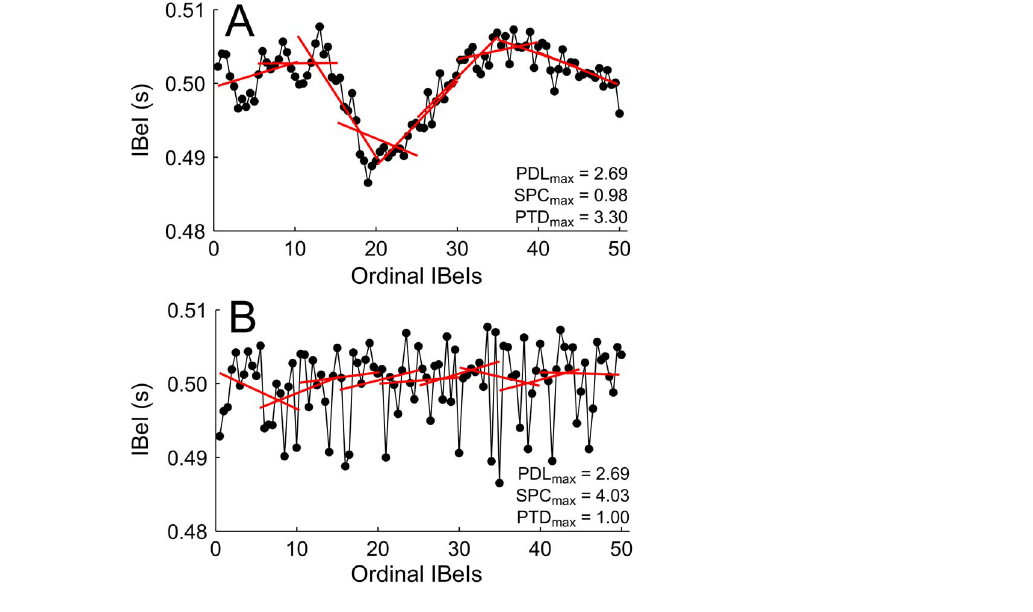
Figure 2. Illustrating the relationship between three measures of temporal instability. Two permutations of the same set of IBeIs are presented; both have identical central tendency and PDL max statistics. The IBeI series in (A) exhibits temporal dependency, with gradual transitions from IBeI to IBeI. The IBeI series in (B) exhibits a more stochastic pattern of IBeI transitions. These differences in temporal structure are reflected in the SPC max and PTD max